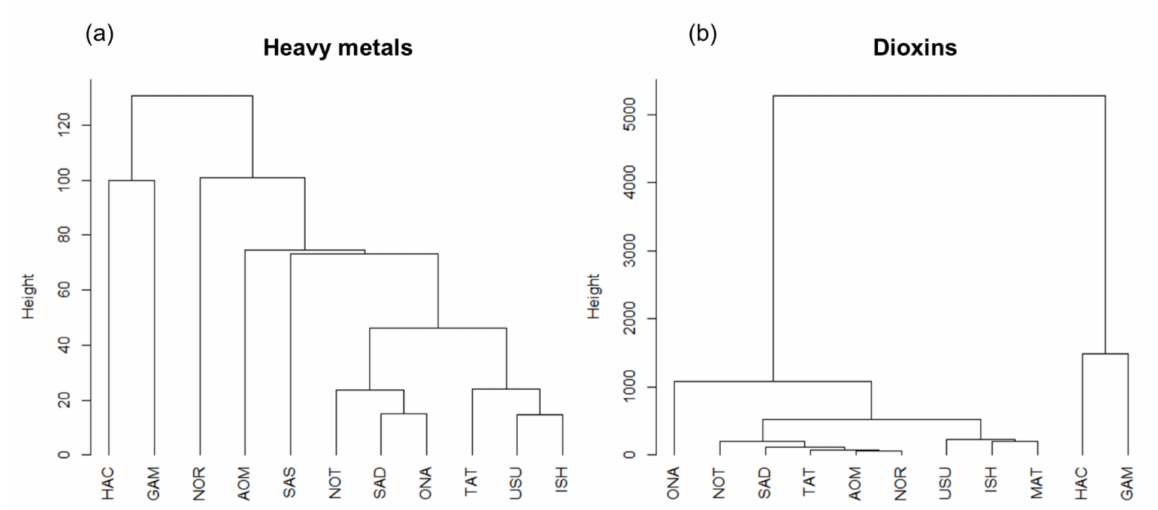
Figure 5. Hierarchical dendrogram for 11 sampling sites obtained using hierarchical cluster analysis with an average linkage method: ( a ) calculated using heavy metal concentrations and ( b ) calculated using PCDD/F and DL-PCB